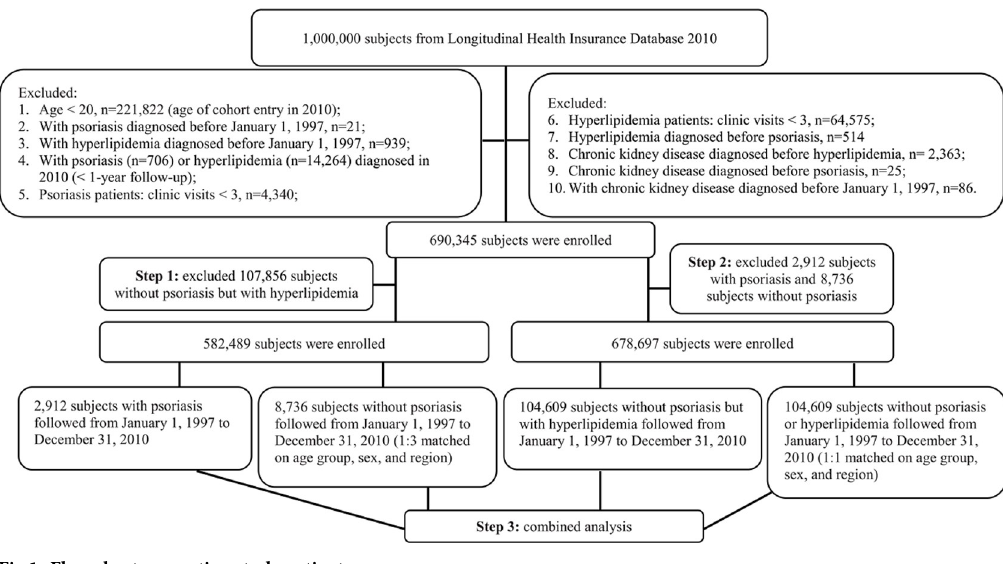
Fig 1. Flow chart presenting study